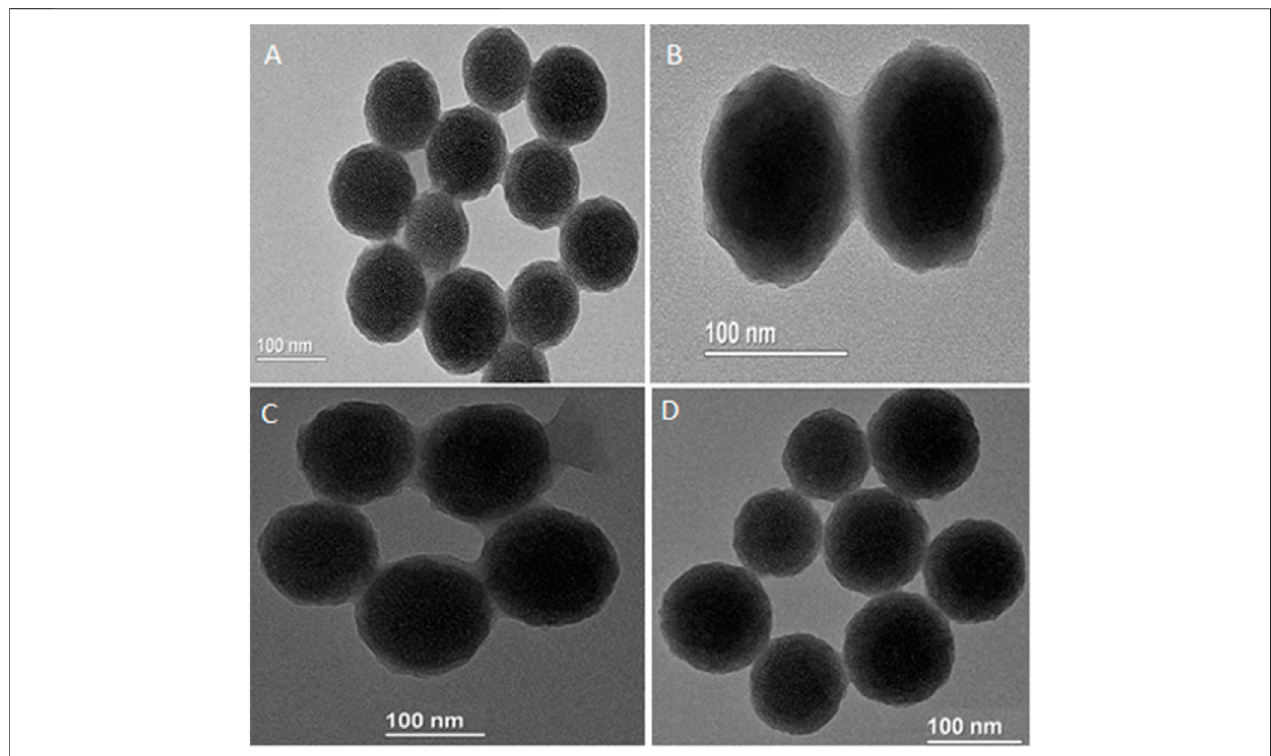
FIGURE 1 | TEM images of (A) MNPs-aspirin particles (size 147.00 ± 6.0 nm) (B) MNP-Asp@PD particles (size 160.7 ± 8.3) (C) MNP-Asp@PD-PG particles (size 197.4 ± 6.4), and (D) MNP-Asp@PD-PG-F particles (size 204.4 ± 6.0).